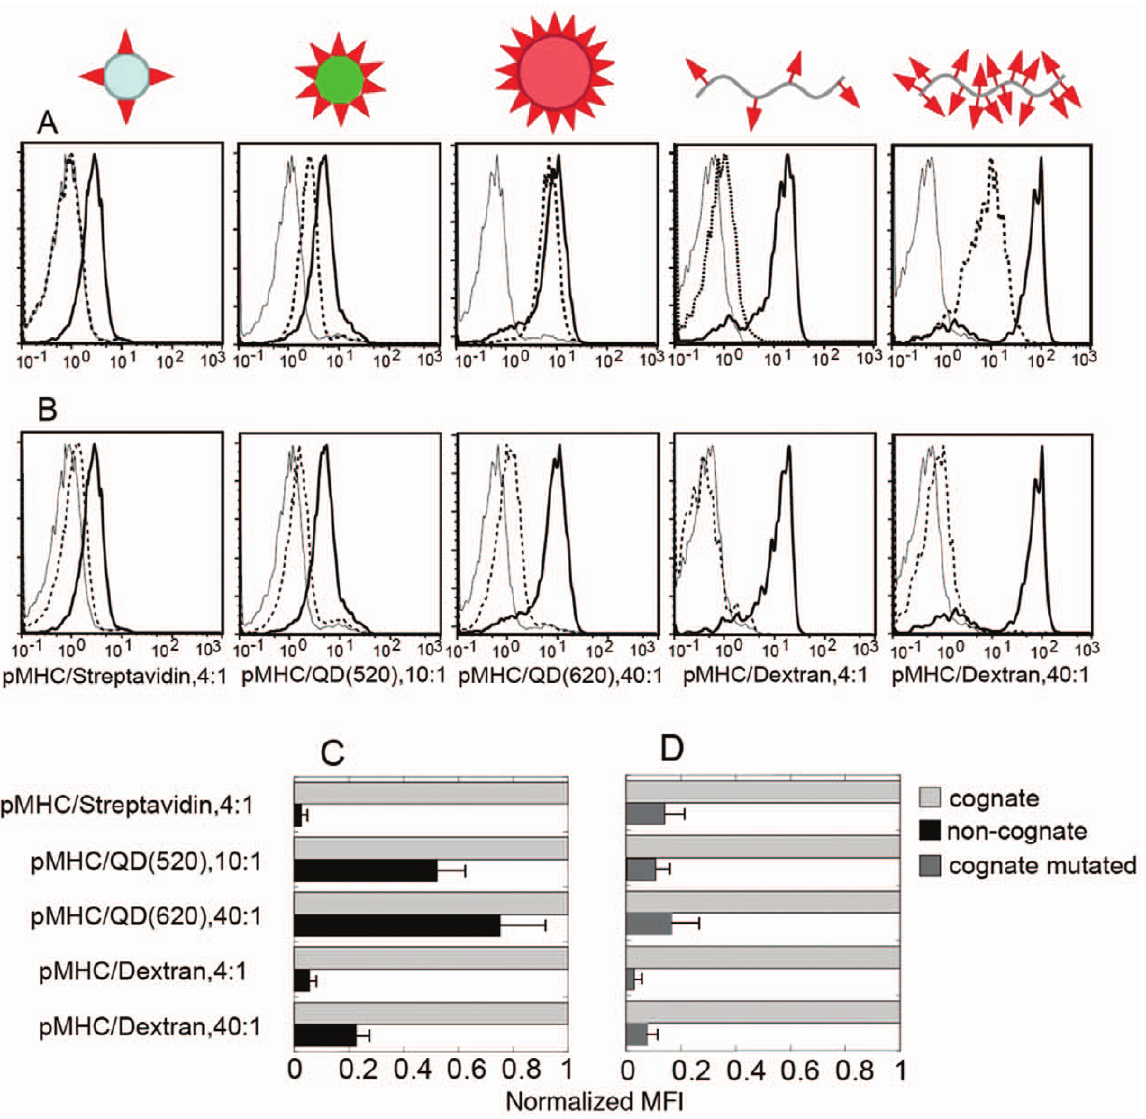
Figure 2. Comparison of the binding of various cognate and noncognate pMHC oligomers to CD8 CTL. A. Binding of cognate (IV9-HLA- A2, bold solid line) and noncognate (Tax-HLA-A2, dotted line) pMHC ligands assembled on different scaffolds to 68A62 CTL as established by flow cytometry. The CTL were incubated with each oligomer at 20 nM for 30 min prior to the analysis. Mutant HLA-A2(A245V) loaded with noncognate peptide (Tax) was used to produced oligomers which were utilized as negative controls (solid line). B. Binding of different oligomers carrying cognate peptide (IV9) in association with either intact (bold solid line) of mutated HLA-A2 (A245V) (dashed line) to 68A62 CTL was evaluated. Binding of cognate dextramers in the presence (dashed) or absence (bold solid line) of blocking anti-CD8 antibodies was examined. Other conditions are as in A . Data represent mean 6 s.d. C. Normalized MFI of 68A62 bound to cognate or noncognate pMHC oligomers containing intact HLA-A2 protein. The nature of oligomers and the number of pMHC ligands per oligomer are indicated. Data represent mean 6 s.d. D. Normalized MFI of 68A62 bound to cognate oligomers or cognate oligomers containing pMHC mut with mutated HLA-A2 (A245V) protein. The tested oligomers are as in C .